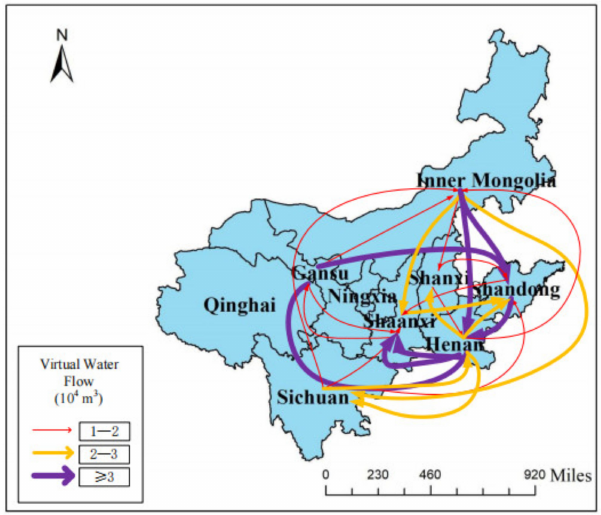
Figure 6. Total virtual water flow of each province in the Yellow River Basin. Note: This figure only shows the flow direction of virtual water trade flow greater than 10 4 m 3 .